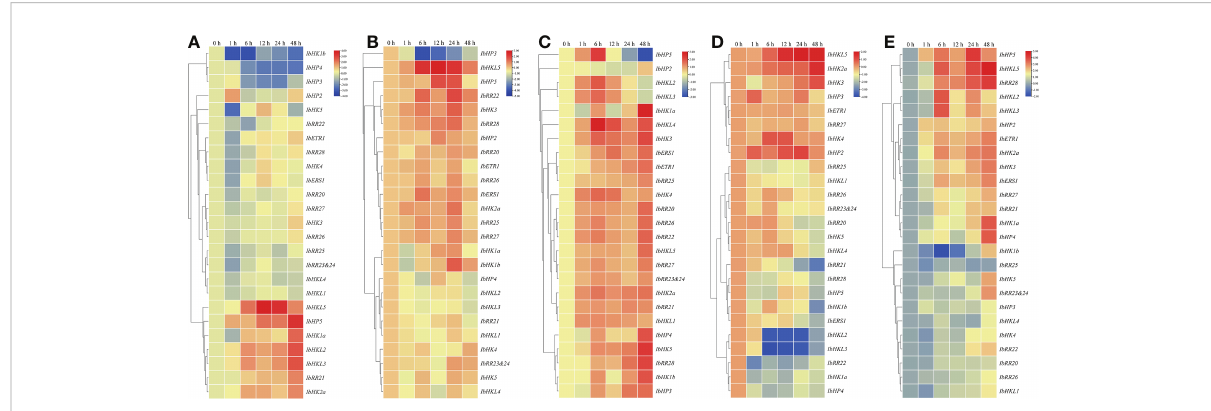
FIGURE 7 Heat map representation for the response patterns to drought (A) , salt stress (B) , heat (C) , cold stress (D) , and exogenous ABA (E) treatment TCS genes in Ipomoea batatas . The expression levels of genes are presented using fold-change values transformed to Log 2 format compared to control.